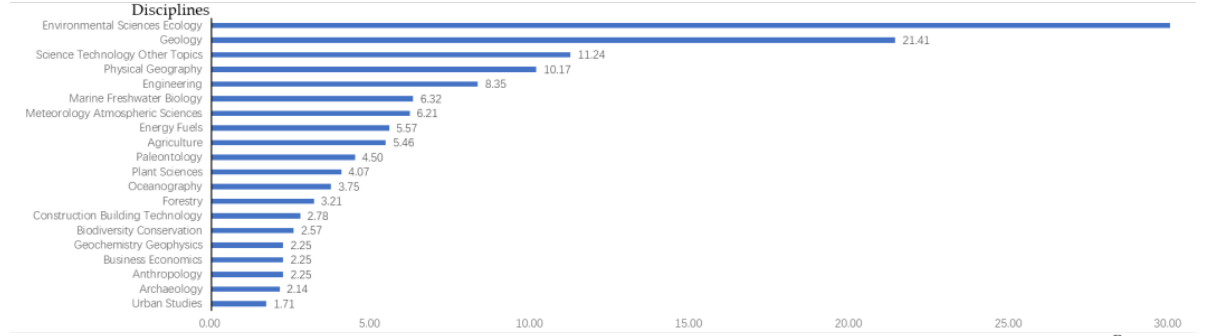
Figure 3. Distribution of RCHSCC disciplines (top 20).